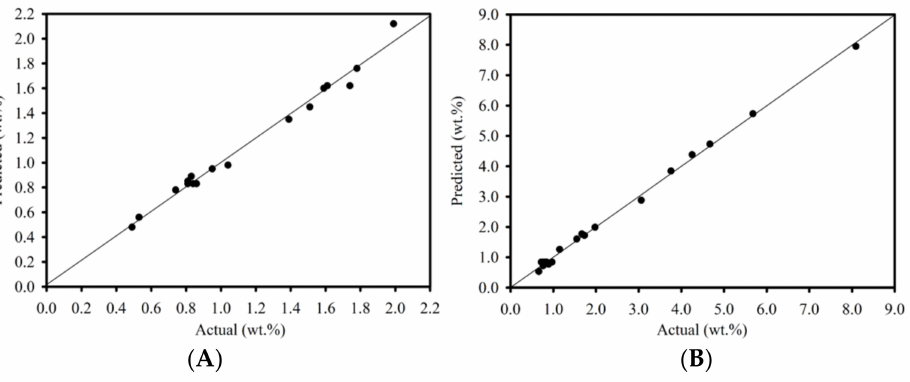
Figure 2. Predicted FFA content versus experimental FFA content ( A ) heterogeneous catalytic reaction and ( B ) homogeneous catalytic